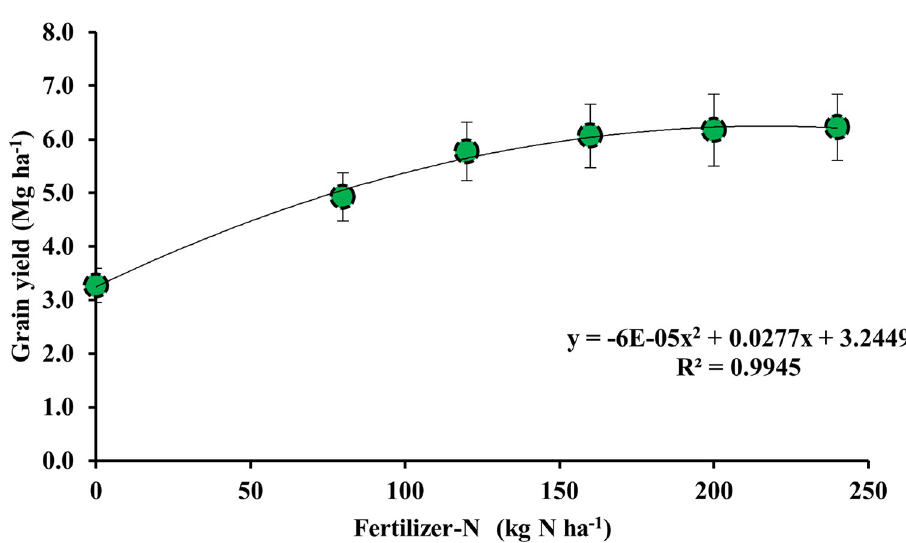
application did not significantly increase the harvest index of wheat. The interaction effect of fertilizer-N and K on wheat grain and the harvest index was non-significant. Fertilizer-K appli- cation at K resulted in significant increase in wheat straw yield. Fig 2 illustrates that wheat 90 grain yield increased in non-linear way with fertilizer-N application, and the relationship between fertilizer-N application rates and wheat grain yield could best be described by Eq 2. Wheat grain yield ð Mg ha (cid:0) 1 Þ